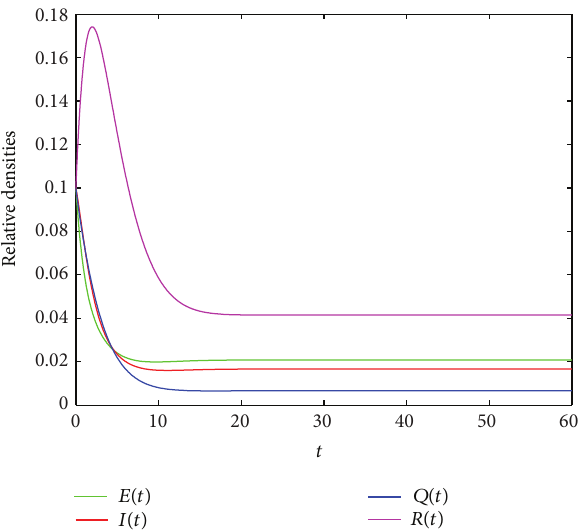
Figure 4: Global attractivity of infection